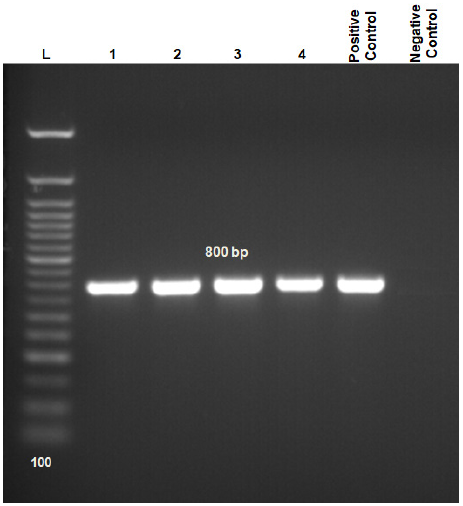
Fig. 2. Agarose gel electrophoresis (1.5%) of PCR amplification for DNA showing 800bp of aflatoxin regulatory gene-1 ( aflR1 ). Lane 1-4 = samples; compared with control positive and control negative; Lane (L) DNA ladder 100 bp.